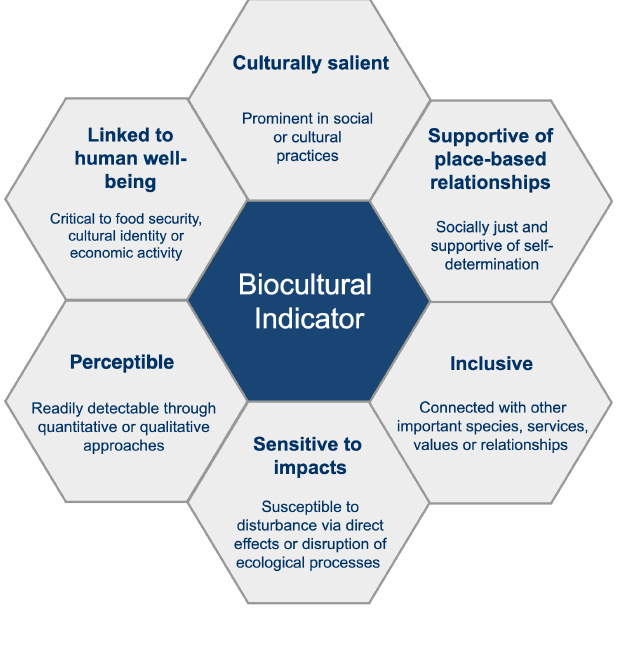
Fig. 1 . Six emergent criteria (culturally salient, supportive of place-based relationships, inclusive, sensitive to impacts, perceptible, and linked to human well-being) that can be considered in the development of biocultural indicators for use in environmental management and